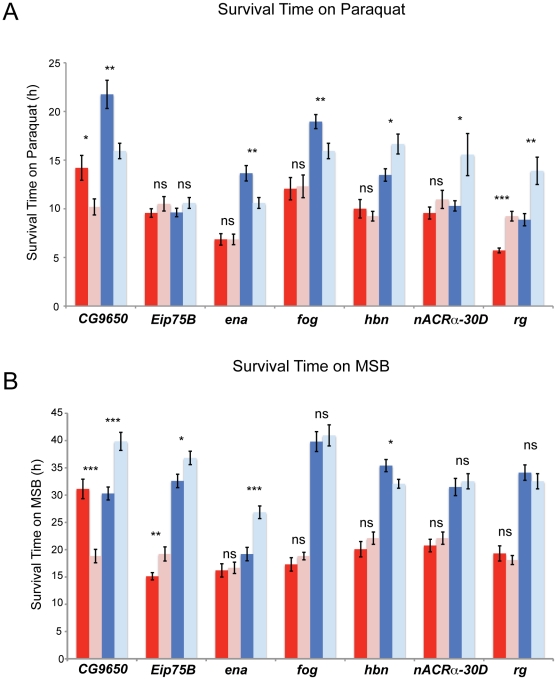
Validation of candidate oxidative stress susceptibility genes using mutants.Seven mutants CG9650BG01024, Eip75BBG02737, enaBG02189, fogBG01196, hbnMB04955, nAcRα-30DMB06675, and rugoseMB01845 were tested for each sex and treatment along with their corresponding control. The averages are color coded: red, female mutant; pink female control; blue, male mutant; light blue, male control. All mutants were homozygous. (A) Survival time on paraquat. (B) Survival time on MSB. *: 0.01≤P≤0.05; **: 0.001≤P≤0.01; ***: P<0.001; ns: P>0.05.